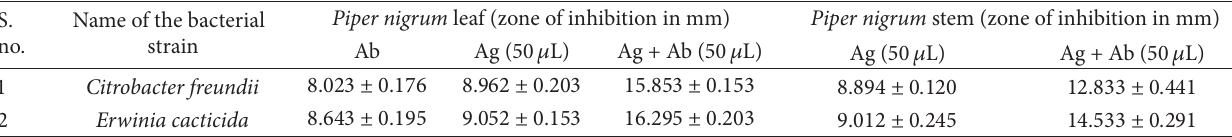
Table 2: Evaluation of antibacterial activity of silver nanoparticles synthesized by using leaf and stem extract of Piper nigrum . S.